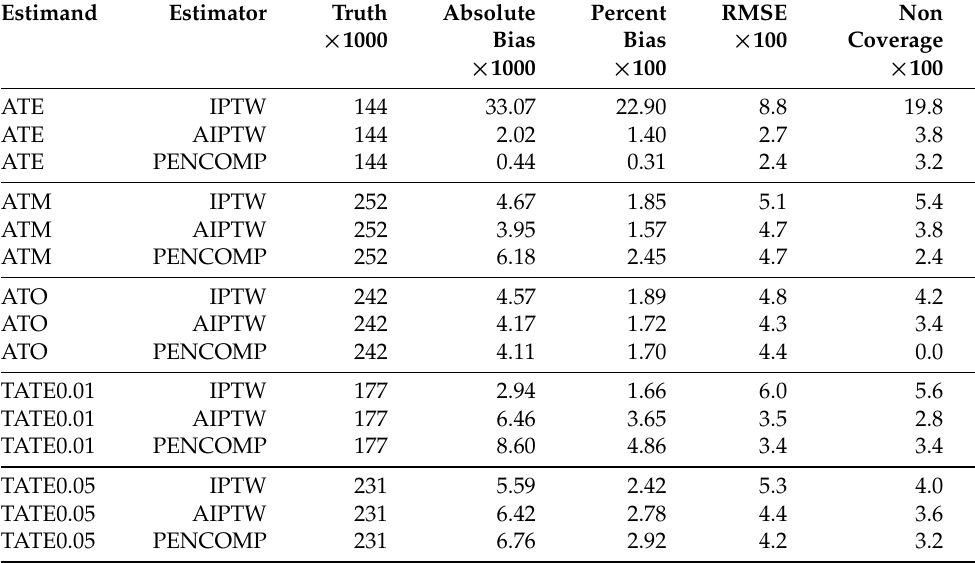
Table 4. Empirical bias (in absolute and percentage), RMSE, and 95% CI (non) coverage, across the methods for a binary outcome in the scenario where both the propensity score and the outcome models were correctly specified. Results were based on 500 simulations with sample size of 500; 500 bootstraps were used to estimate standard errors for the weighted estimators and 200 complete datasets for PENCOMP. ATE = Average treatment effect; ATM = average treatment effect on an evenly matchable set; ATO = average treatment effect on the overlap population; TATE α = truncated average treatment effect with a truncation at a pre-defined α level.